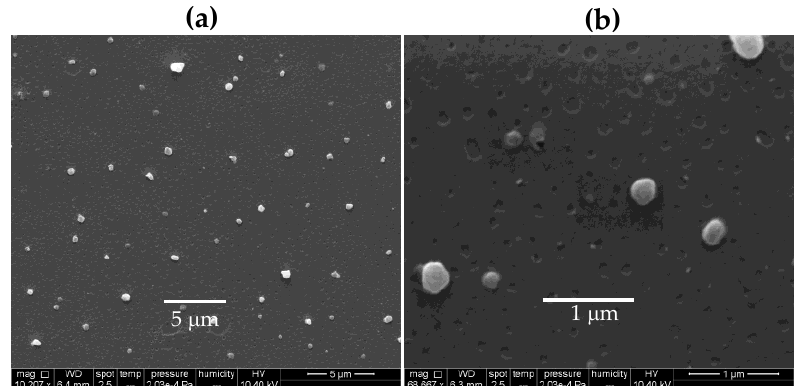
Figure 1. Scanning electron microscopy (SEM) of poly (diallyldimethylammonium chloride) (PDDA)/ ovalbumin (OVA) nanoparticles (NPs) at [PDDA] = 0.01 mg·mL −1 and [OVA] = 0.1 mg·mL −1 under low (a) and high magnification (b) . The mean diameter (D) of dried NPs from ImageJ software was D = 234 ± 42 nm.